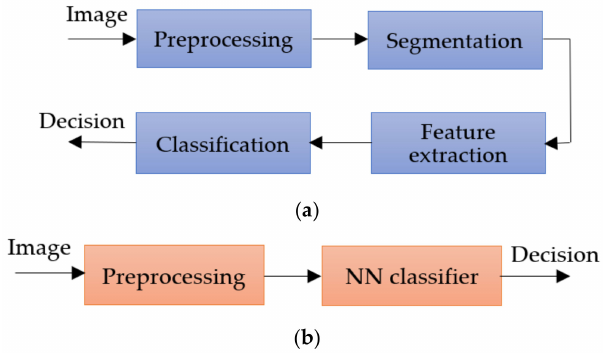
Figure 2. Methods workflow for Me detection: ( a ) classical method, ( b ) NN